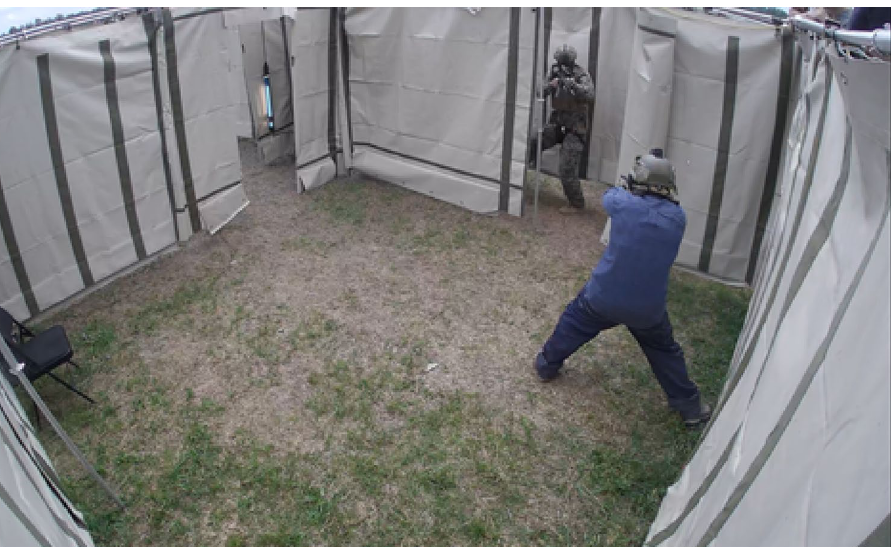
Figure 5. Sample image of the multi-room environment for the force-on-force training assessment. The participant (facing camera) searched the environment and encountered three role players. This image depicts the armed and aggressive hostile role player (back to